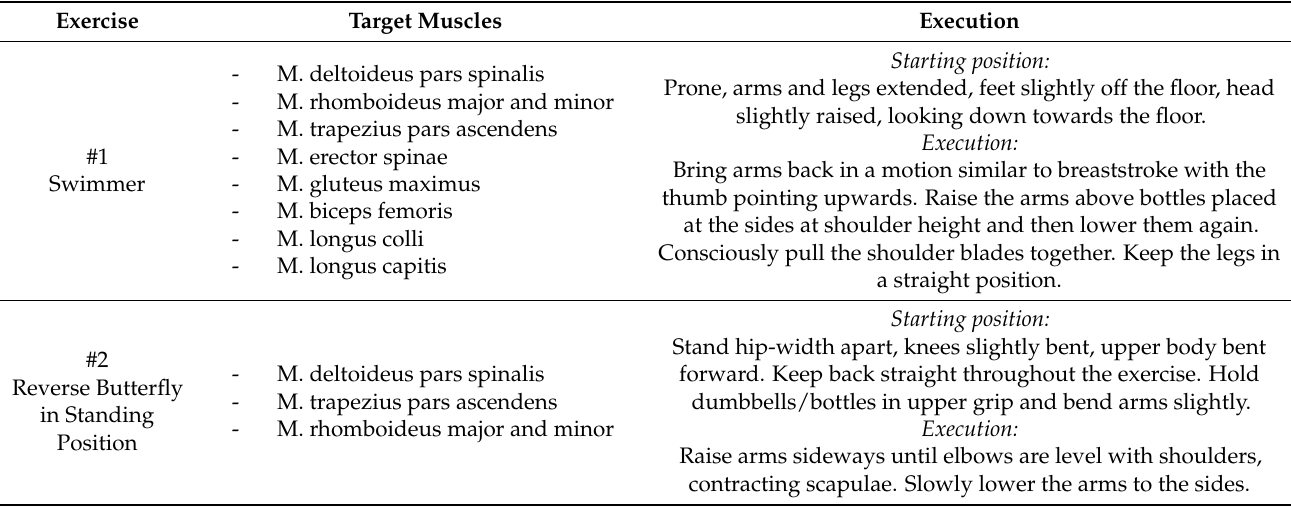
Table 3. Description of the exercises and the targeted muscle